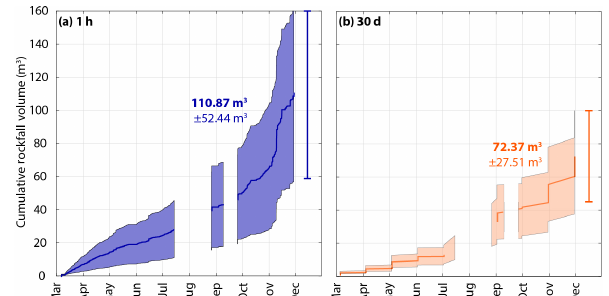
Figure 13. Cumulative rockfall volumes measured though the mon- itoring period, using data from all 11 monitoring intervals. The re- sults show that far higher volumes of material, up to twice those recorded by 30 days of monitoring, are measured at sub-daily in- tervals. The times of pairwise change detections are recorded as the date of the first scan, rather than the second. As a result, although all scan intervals record a significantly increased rate of rockfall activ- ity during November, this appears earlier on the plot for longer scan intervals. The total estimated volumes are not included for compar- ison as change detections cannot be recorded up to the final day of monitoring for longer time intervals (30